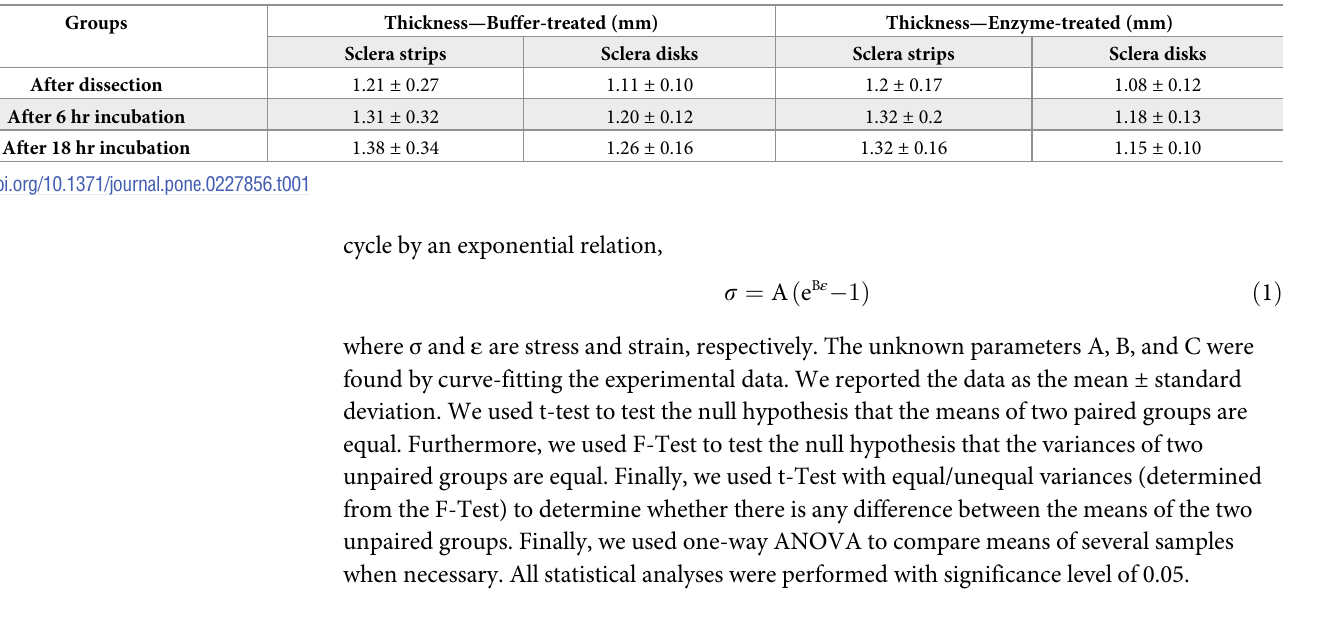
Table 1. Thickness variations of porcine posterior strips and discs during the experimental protocol, see Fig 1.